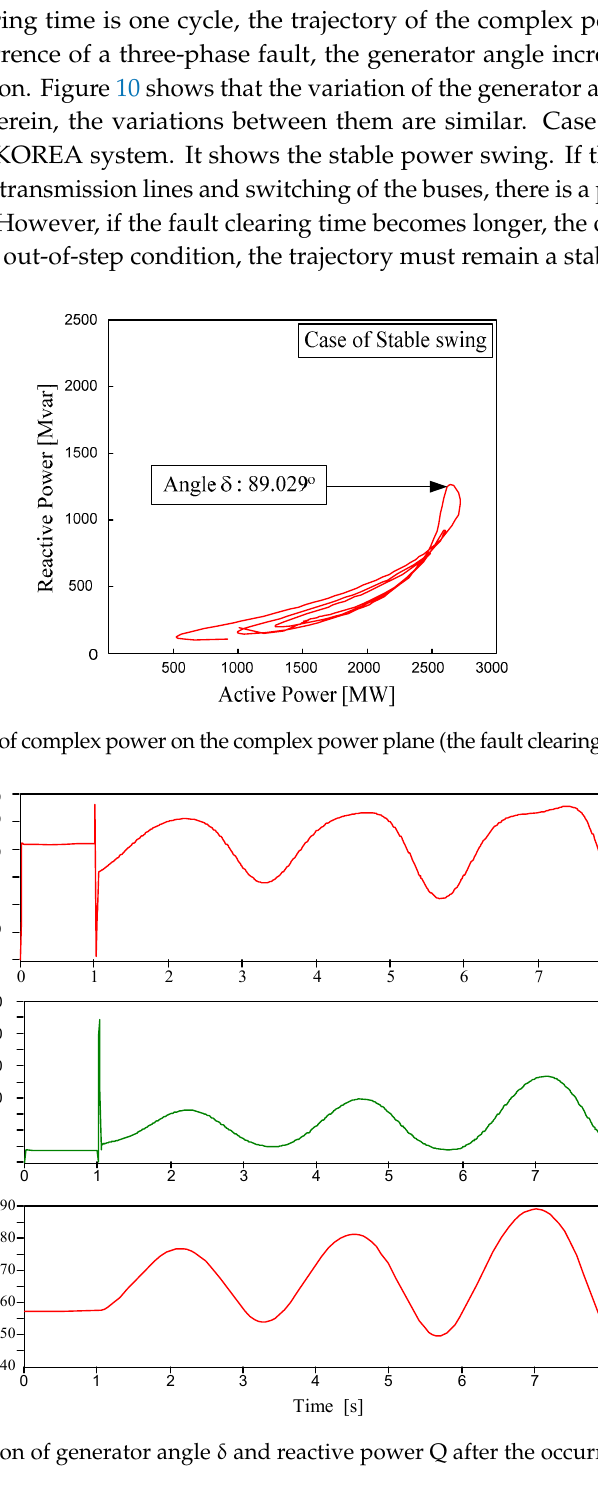
Figure 8. Test model of the power system .